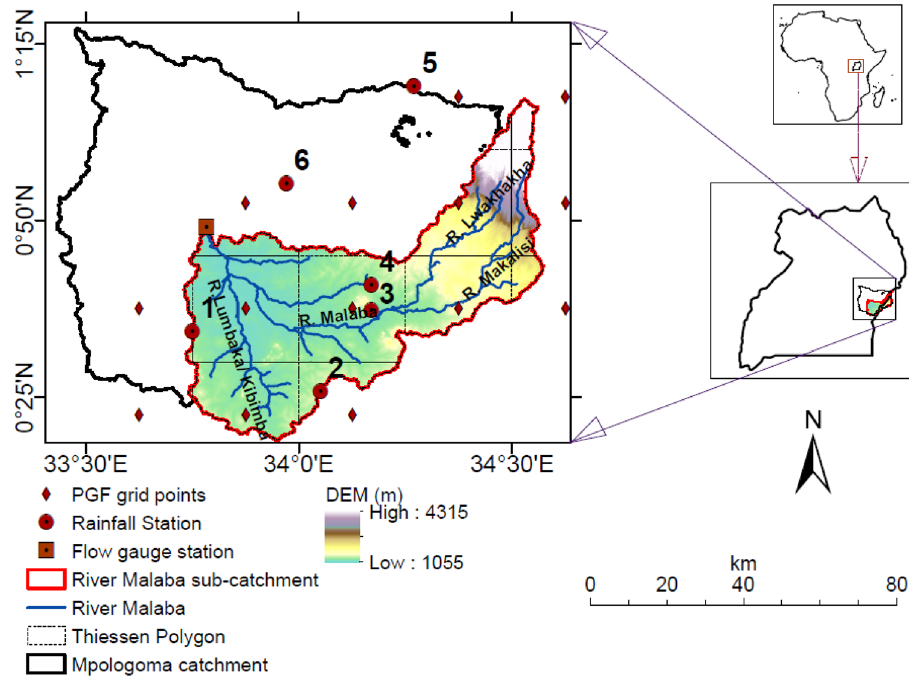
Fig. 1 Location of River Malaba